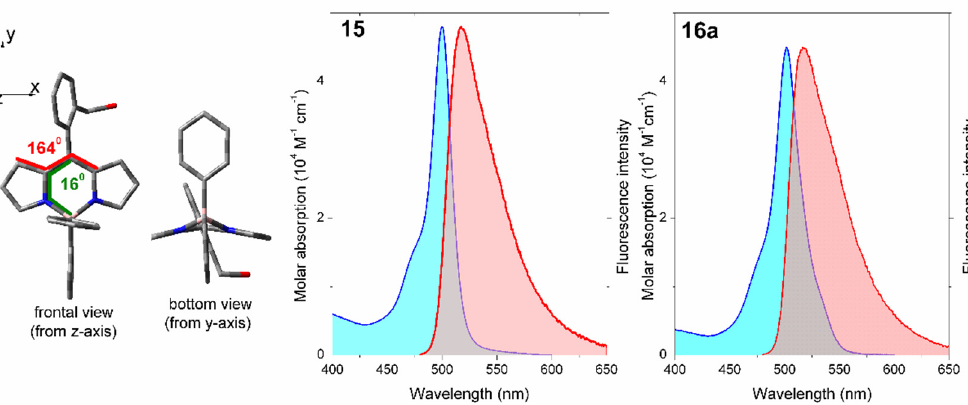
Figure 2. Absorption (in blue) and normalized fluorescence (in red) spectra of BODIPY 15 and its glycosylated derivative 16a in diluted solution of ethyl acetate. The spectral profiles of 10 fully resemble those of 16a . The excited state optimized geometry of 15 in two different views is also enclosed with key dihedral angles to show the bending of the chromophore. Table 1. Photophysical 1 and laser 2 properties of BODIPY 15 , and glycosylated derivatives 16a and 10 , in ethyl acetate. For the sake of comparison, the corresponding photophysical data of the F-BODIPY counterpart (in ethanol) have been added. For additional photophysical data, see Table S1. Compound